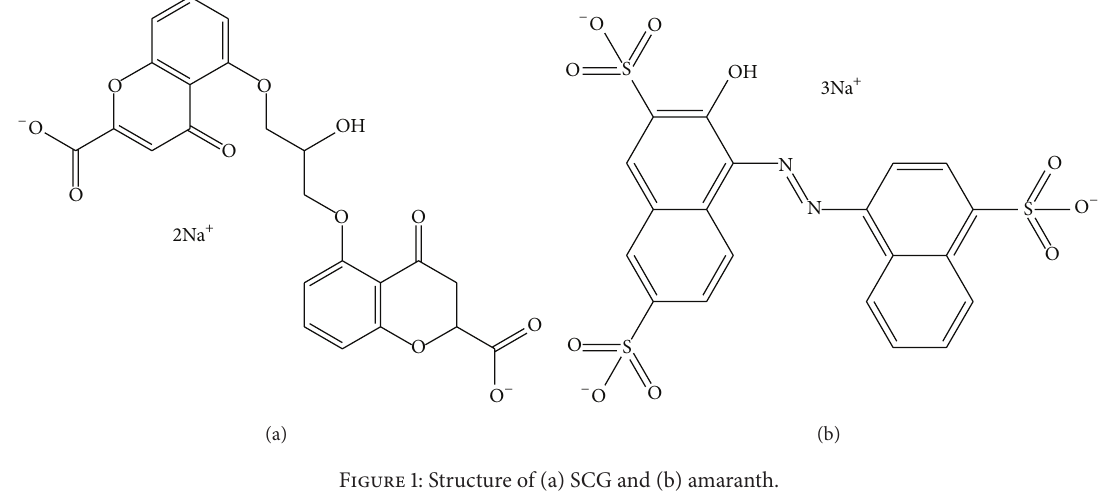
Figure 1: Structure of (a) SCG and (b) amaranth.